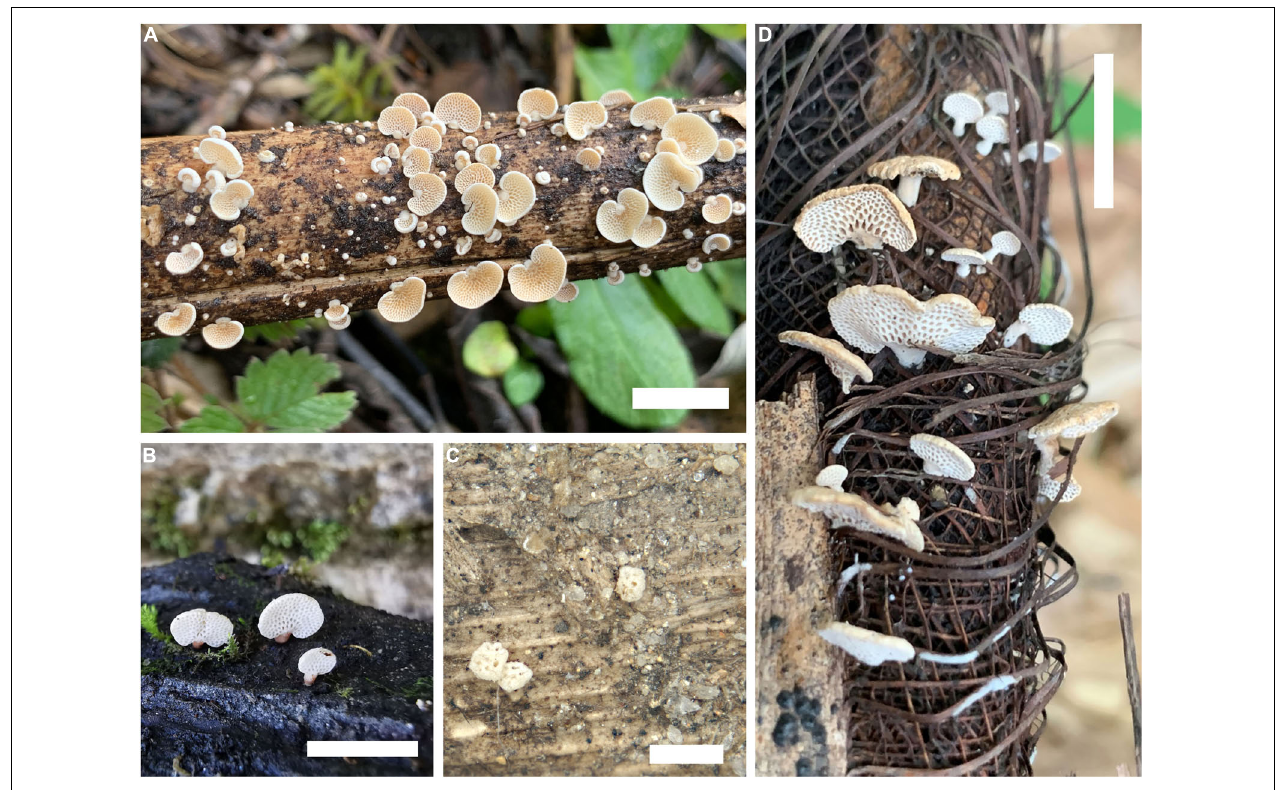
FIGURE 4 | In situ photo documentations of Panellus species. (A) P. alpinus (holotype); (B) P. crassiporus (Dai 23663); (C) P. minutissimus (holotype); (D) P. palmicola (Dai 22334) [Scale bars: (A,B,D) = 5 mm; (C) = 1